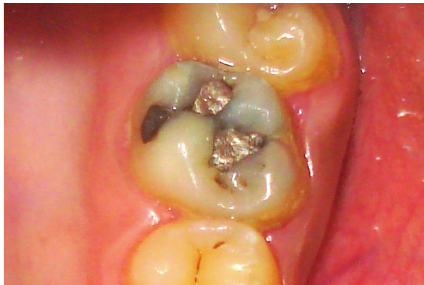
Figure 3: The tooth was restored with a posterior composite resin.